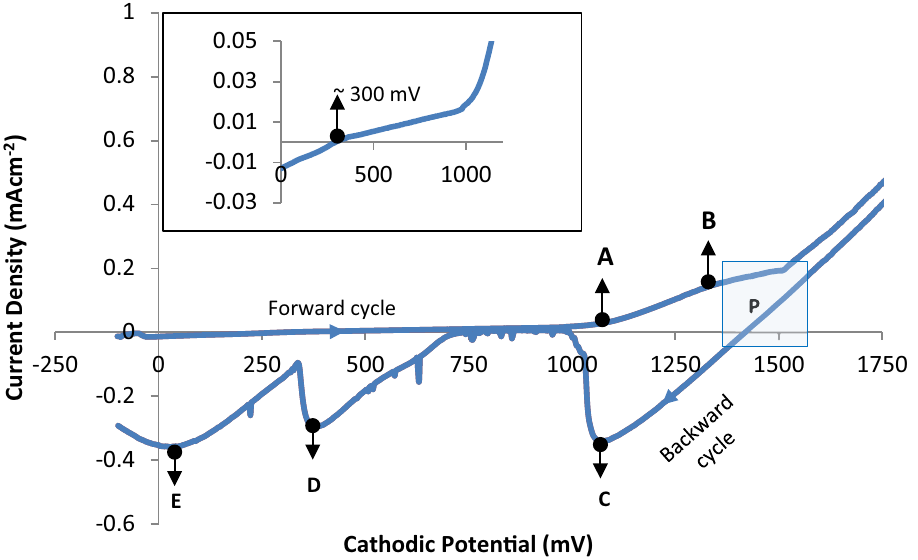
Figure 2. Cyclic voltammogram of electrolyte containing 1.00 M CdSO 4 , 0.12 M MnSO 4 and 5.0 ml of dissolved